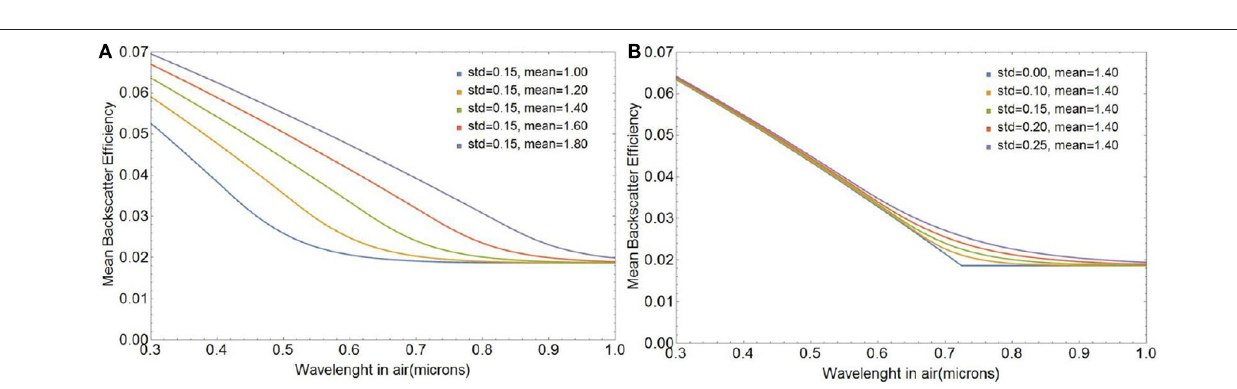
Frontiers in Marine Science |